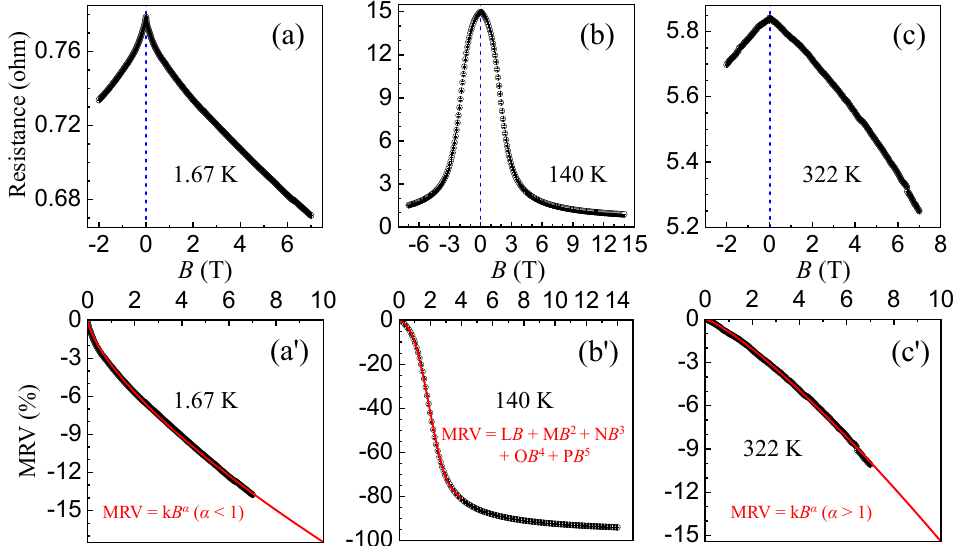
Figure 7. (color online) Applied-magnetic-field-dependence of resistance within the crystallographic ab plane ( ⊥ B ) of a La 1.37 Sr 1.63 Mn 2 O 7 single crystal at 1.67 K ( a ), 140 K ( b ), and 322 K ( c ). Error bars are standard deviations and are embedded into the symbols. ( a’ – c’ ): the calculated MRV (circles) versus the applied magnetic field B , corresponding to figures ( a – c ), respectively. The solid lines represent theoretical fits; see the detailed analyses in the text. Error bars were estimated based on the law of propagation of errors, and some were embedded into the